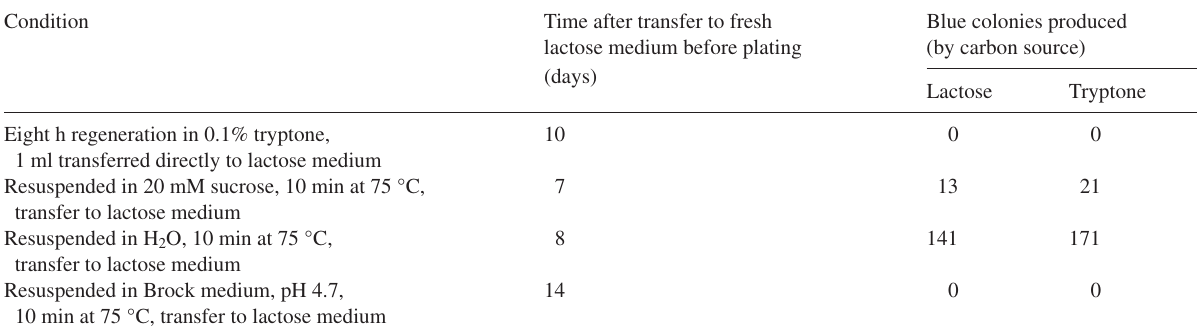
Table 1. Post-electroporation